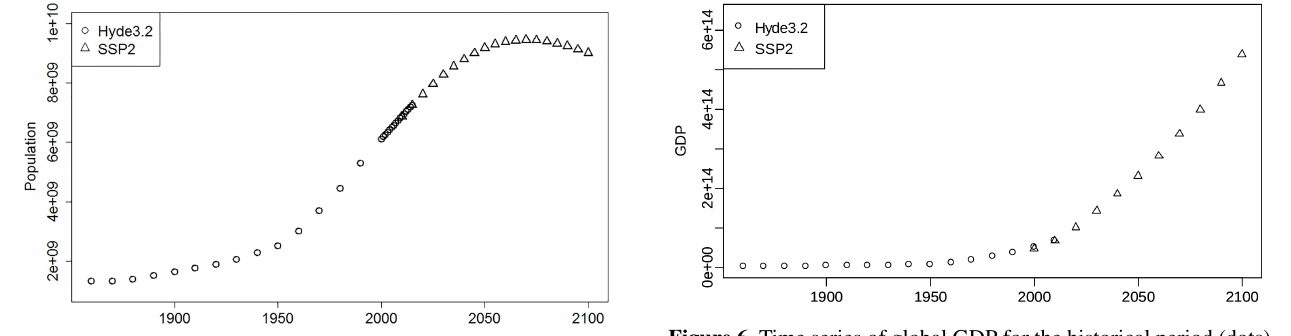
Figure 6. Time series of global GDP for the historical period (dots) and future projections following the SSP2 storyline